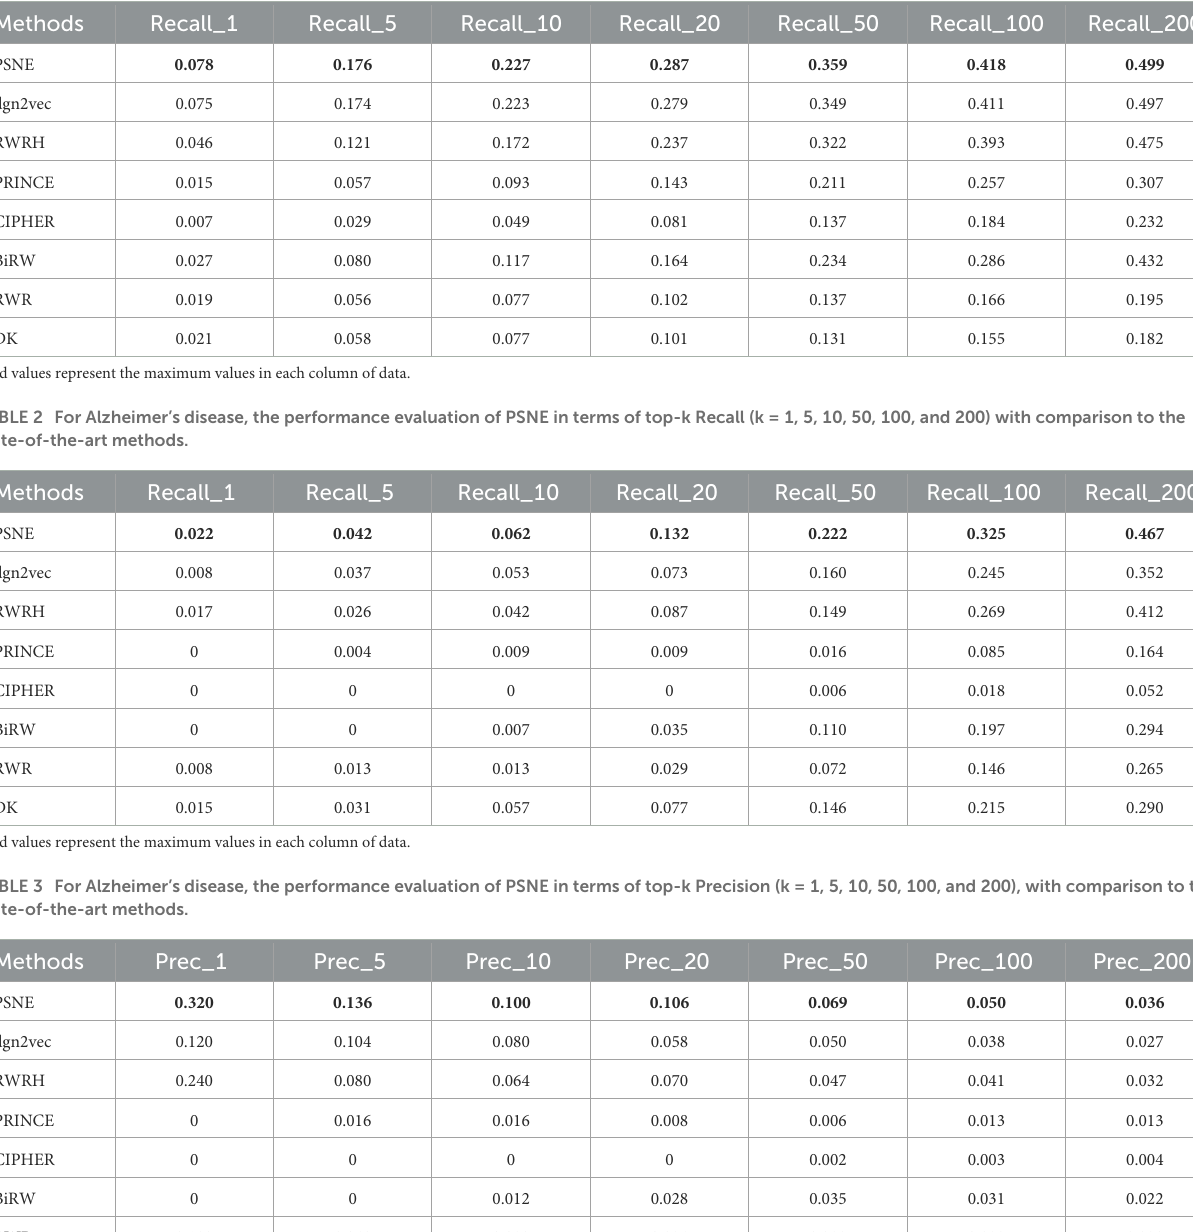
TABLE 1 Performance evaluation of PSNE in terms of top-k Recall (k = 1, 5, 10, 50, 100, and 200), with comparison to the state-of-the-art methods.